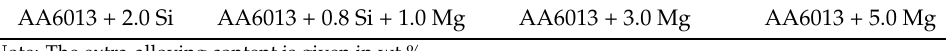
Table 2. The experimental aluminum alloys used in the present work. AA6013 + 2.0